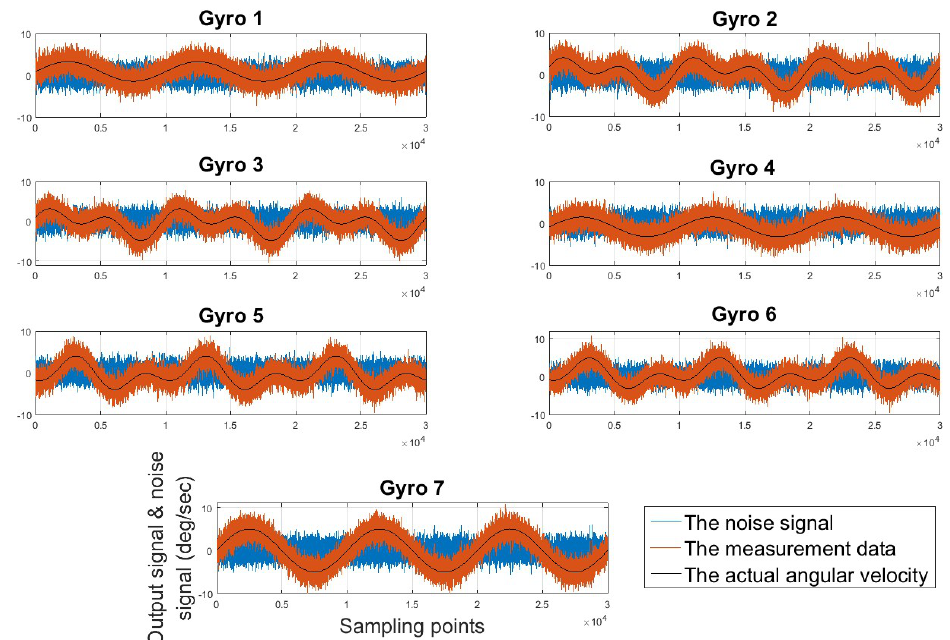
Figure 9. The signal generator of a single gyro.